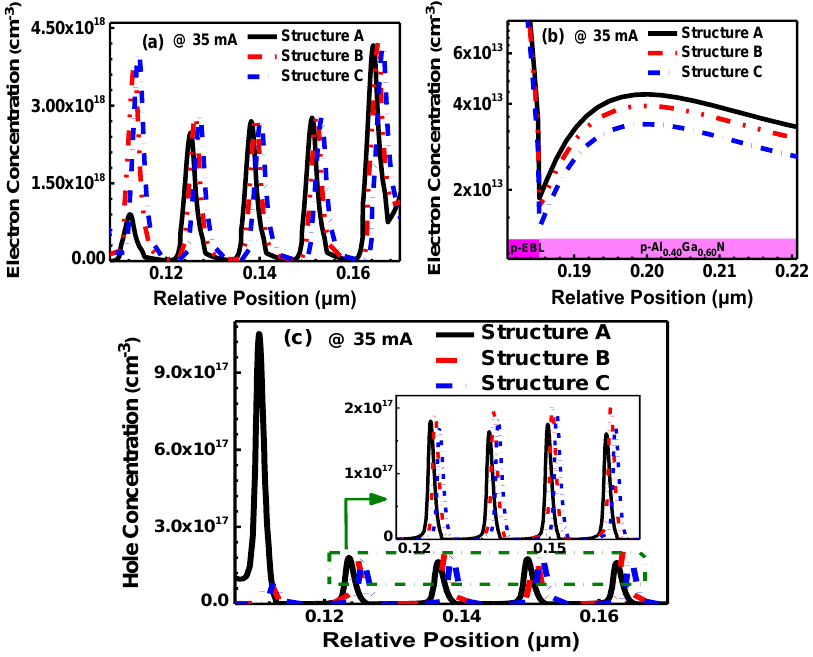
Figure 5. Electron concentration profiles ( a ) in the MQWs; ( b ) in the hole supplier layers; and ( c ) hole concentration profiles in the MQWs for Structures A, B, and C, respectively. Data are collected at the injection current level of 35 mA.